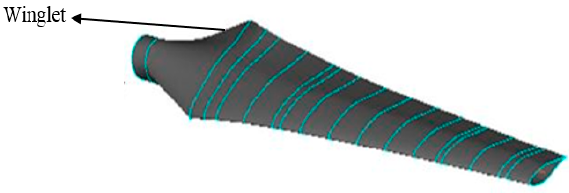
Figure 11. Airfoil with winglet [116].